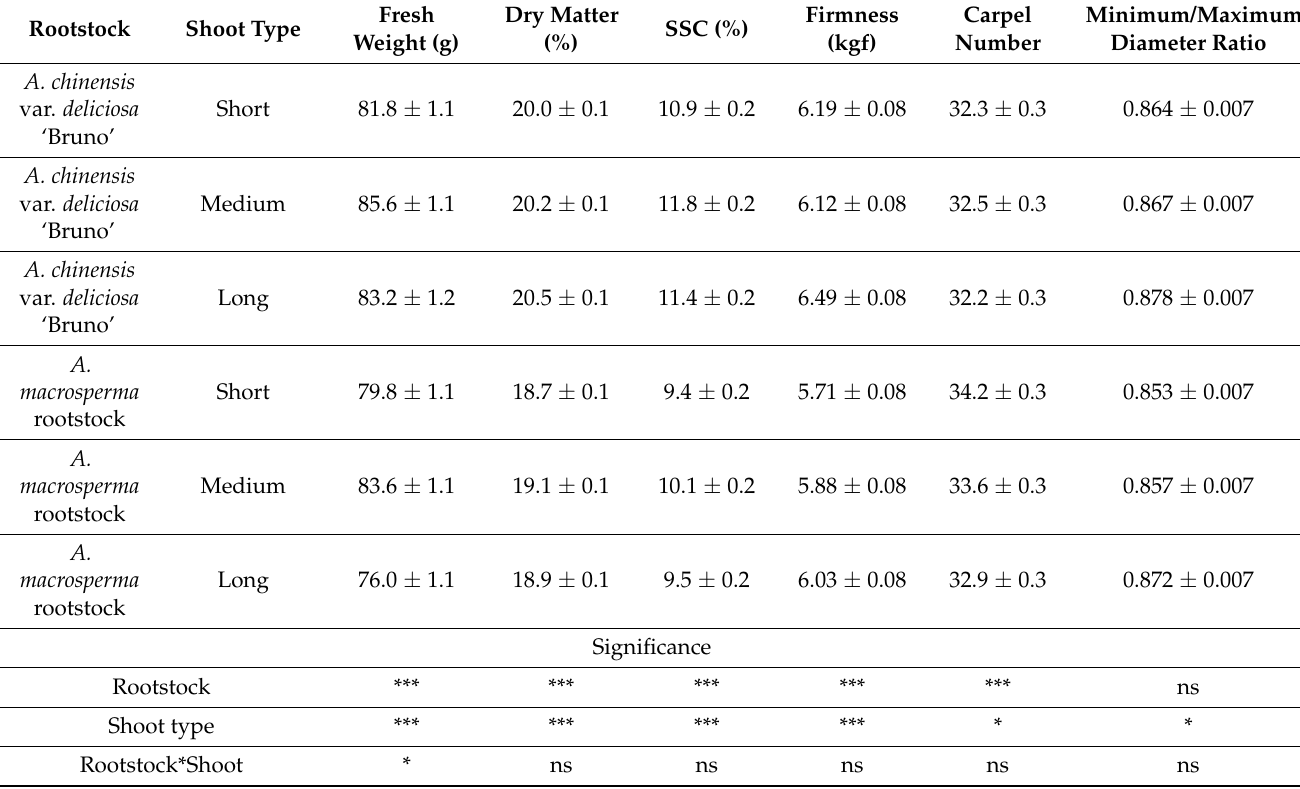
Table 1. The effect of rootstock ( Actinidia chinensis var. deliciosa ‘Bruno’ or A. macrosperma clonal rootstock) and shoot type (short, medium or long) on A. chinensis var. chinensis ‘Zes008’ fresh fruit weight, fruit dry matter, soluble solids content (SSC), firmness (kilogram force (kgf), carpel number and minimum/maximum diameter ratio at harvest (168 DAA). Data are means ± SEM, n = 50. * p < 0.05; *** p < 0.001; ns: not significant.